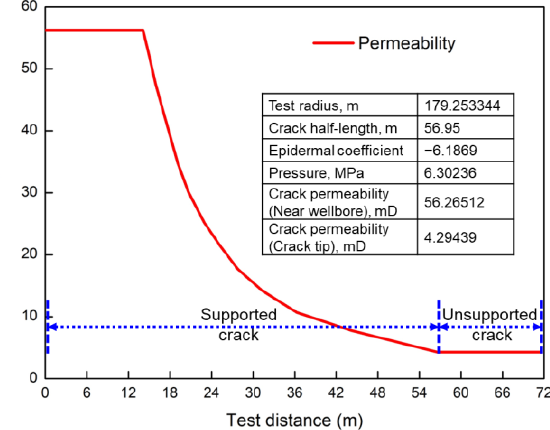
Figure 23. Static fracturing crack pressure drop testing after graphene – foam – cement slurry fracturing.